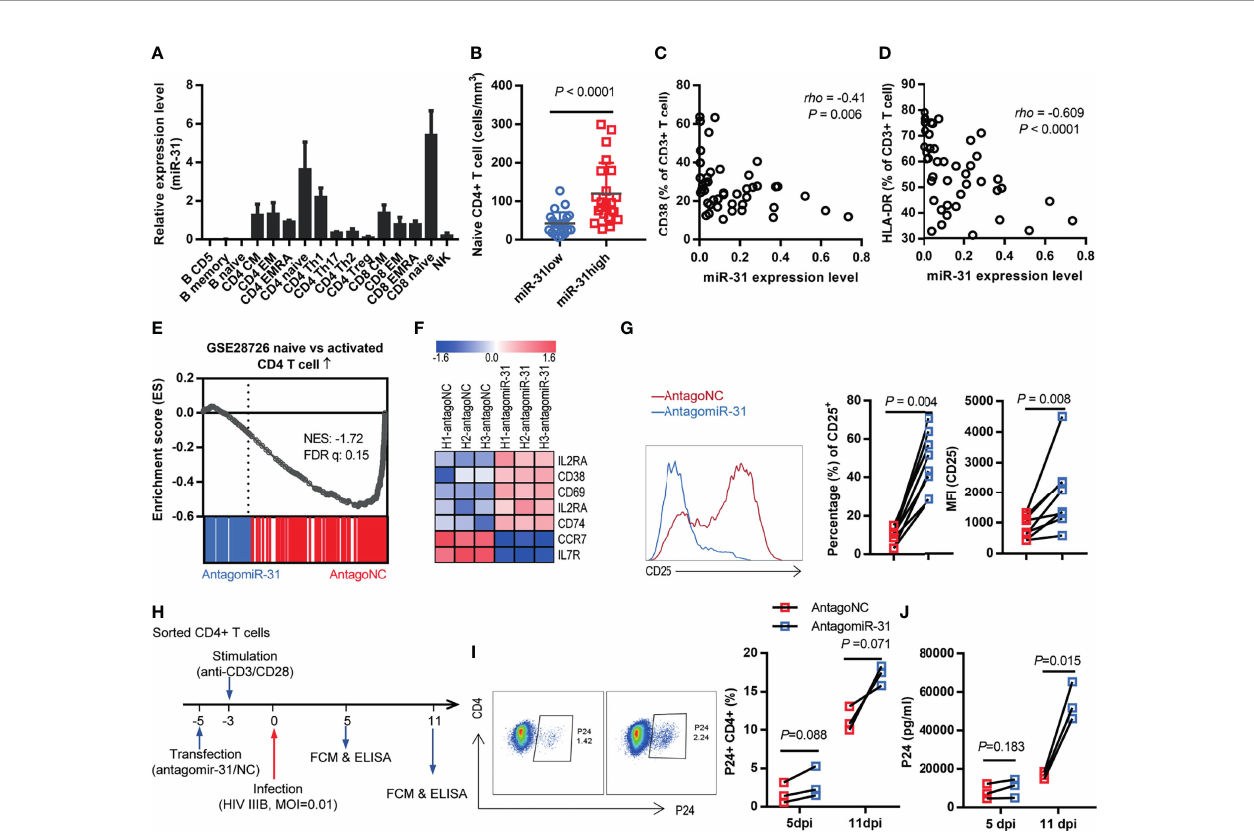
FIGURE 2 | Loss of miR-31 triggers CD4+ T cell activation. (A) miR-31 levels in different immune cell subtypes. Data were obtained from a miRNA RTqPCR data from Rossi et al ’ s work (see the text for reference). (B) Comparison of absolute naïve CD4+ T cell counts in blood of HIV-1 infected individuals (FBD, n = 50) strati fi ed by miR- 31 expression. (C, D) Correlation between miR-31 levels and frequencies of CD38+ T cells (C) or HLA-DR+ T cells in blood of HIV infected individuals (FBD, n=44) (E) Gene set enrichment analysis (GSEA) of “ naïve ” signature in antagomiR-31- versus antagoNC- treated naïve CD4+ T cells. NES, normalized enrichment score. (F) Heatmap of representative genes associated with activation versus naïve state of T cells. Shown is log2 fold changes of gene expression in antagomiR-31-treated naïve CD4+ T cells relative to that in antagoNC-treated cells (n=3). (G) Effects of antagomiR-31 treatment on CD25 expression of naïve CD4+ T cells, assessed by frequency of CD25+ cells and median fl uorescent intensity (MFI) of CD25. Average fold changes were 4.45 and 2.25, respectively (n = 8). Blue, antagomir-31 treated group; red, antagoNC-treated group. Representative FACS data for CD25 were shown in the left panel. (H) Schema of the in vitro assay used for examining the role of miR-31 in HIV-1 infection. CD4+ T cells were sorted, followed by transfection with antagomiR-31 or antagoNC. After 48 hours, cells were stimulated with a mix of anti- CD3 and anti-CD28 antibodies and infected with HIV-1 IIIB 5 days later. (I, J) Cells and supernatants were collected on days 5 and 11 post infection and respectively subjected to fl ow cytometry for determination of P24-expressing CD4+ T cells (I) and ELISA for quanti fi cation of released P24 proteins (J) (n =